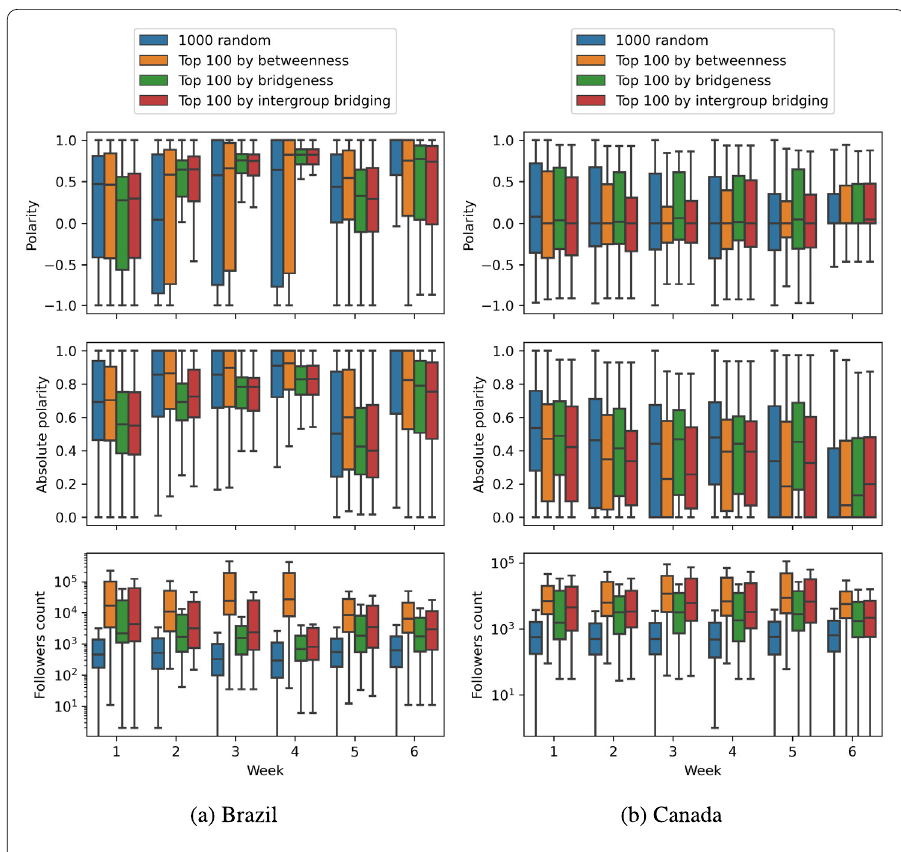
Figure 7 Characterization of top 100 users by each centrality metric